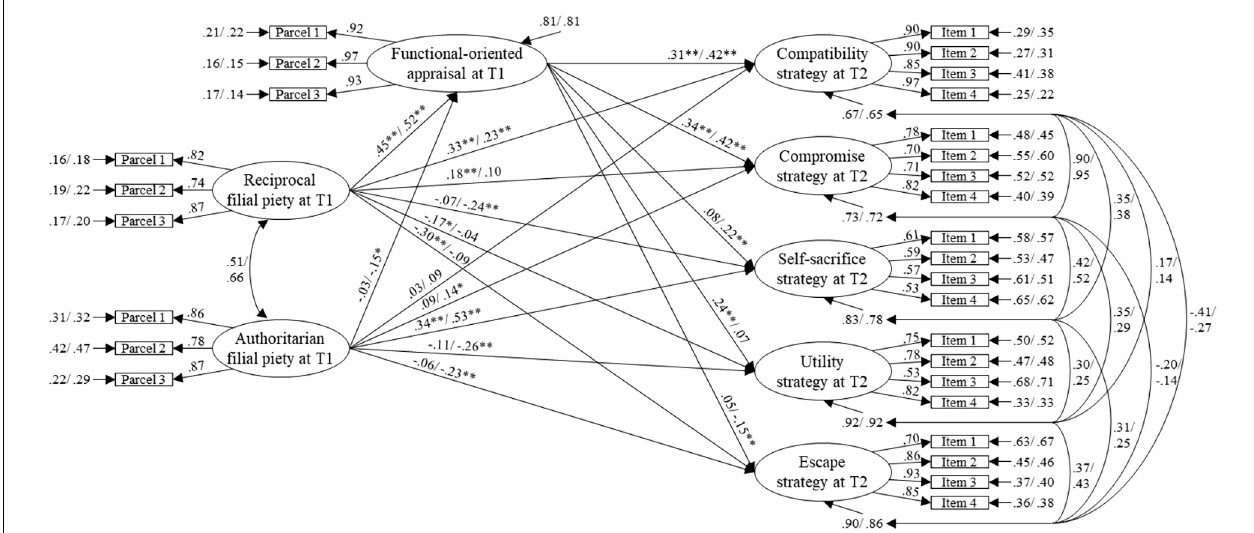
FIGURE 2 | Structural model of dual filial piety, function-oriented appraisal, and parent–adolescent conflict resolution strategy for father–son and father–daughter dataset in Study 2. The influence of the parental education level has been controlled in this model. All coefficients are standardized solutions; the first coefficient is from father–son dataset ( n = 375), the second is from father–daughter dataset ( n = 569). T1, data collected at Time 1; T2, data collected at Time 2 after a 1-year lag. * p < 0.05, ** p < 0.01.